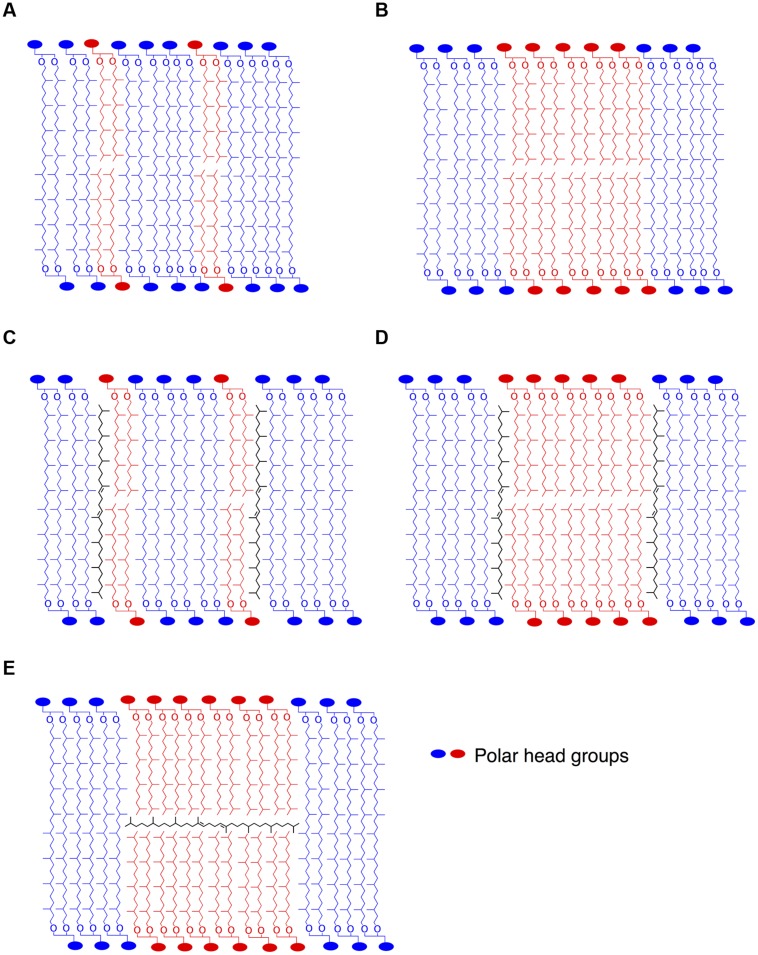
Stylized schematic representation of lipid organization in putative archaeal membrane models. Homogenous lipid mix of di- and tetraether lipids (A), coexistence of monolayer and bilayer domains (B). As proposed by Lanyi et al. (1974) or Gilmore et al. (2013), lycopane-derivatives in the hydrophobic region of the membrane in parallel to the isoprenoid chains in a homogenous (C) or bilayer domain-containing (D) membrane. In contrast, lycopane-derivatives could be inserted in the hydrophobic midplane of bilayer microdomains in parallel to the surface of the membrane (E), as also suggested by Haines (2001) for squalane in membranes of halophiles.